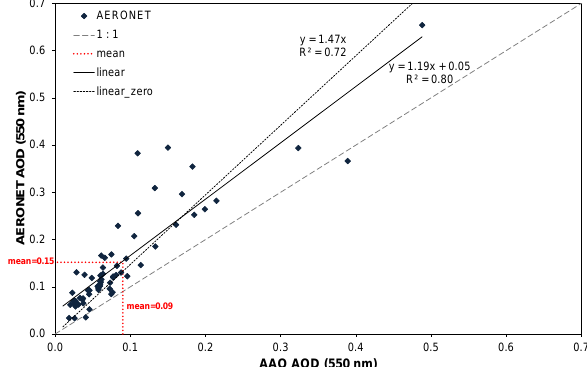
Fig. 2. Comparison of AAO aircraft calculated aerosol optical depth with AERONET optical depth (adjusted to